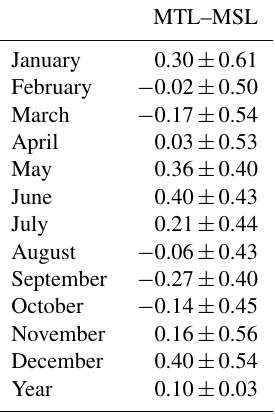
Table 3. Average monthly and annual differences (cm) between MTL and MSL from 1917–2021